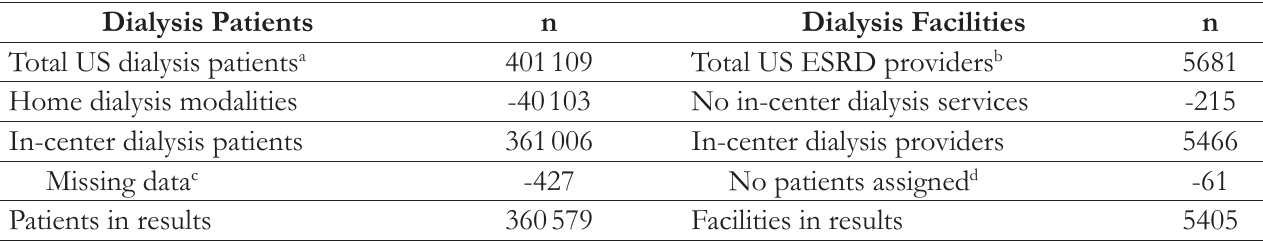
Table 4. Study Cohort of Patients and Facilities